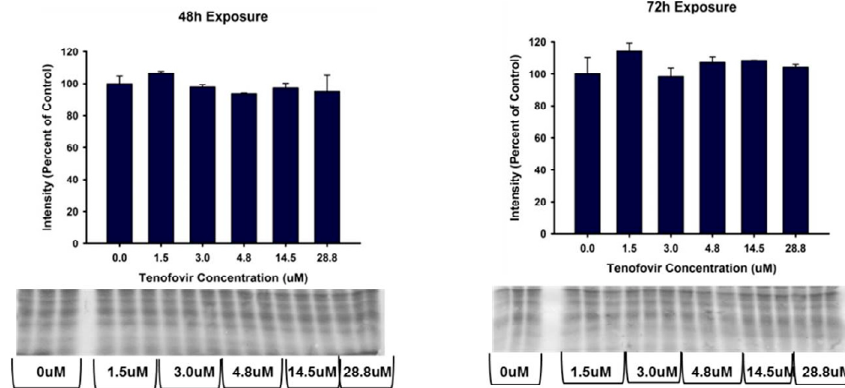
Figure 7. Tenofovir effects on the expression of cleaved caspase 3, 8 and 9 in HK-2 cells. Representative blot and cumulative densitometry for cleaved to total caspase 9 ( A ), caspase 3 ( B ) and caspase 8 ( D ) protein expression following 72 h. Asterisks (* p < 0.05, ** p < 0.01, *** p < 0.001) indicate statistical difference from the vehicle control group; ( C ) Depicts 48 h caspase 8 cleavage. ( E ) four representative blots of MemCode reversible staining for 40 μ g protein loading and cumulative densitometry; blots and densitometry depicted in E correspond to: (top left is for A ) and (top right B ) while (bottom left is representative blot and densitometry for protein loading in C ) and (bottom right is protein loading and representative blot for D ). Each bar represents Mean ± SEM for three independent experiments run with three biological replicates.